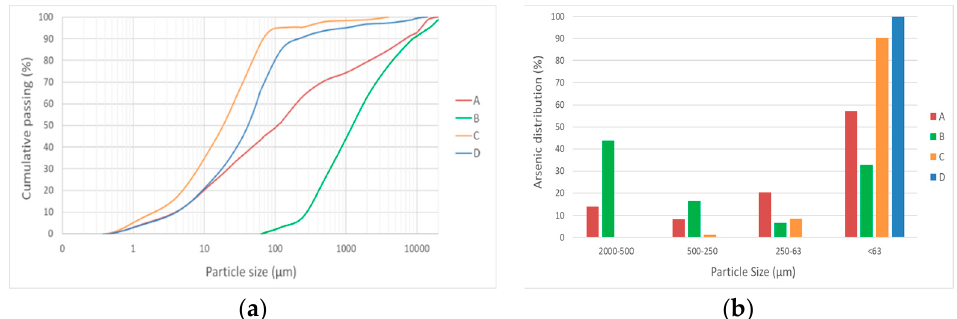
Figure 1. ( a ) Particle-size distribution of samples obtained by compositing wet-sieving and laser dispersion data; ( b ) Arsenic distribution along granulometric fractions in percentage.